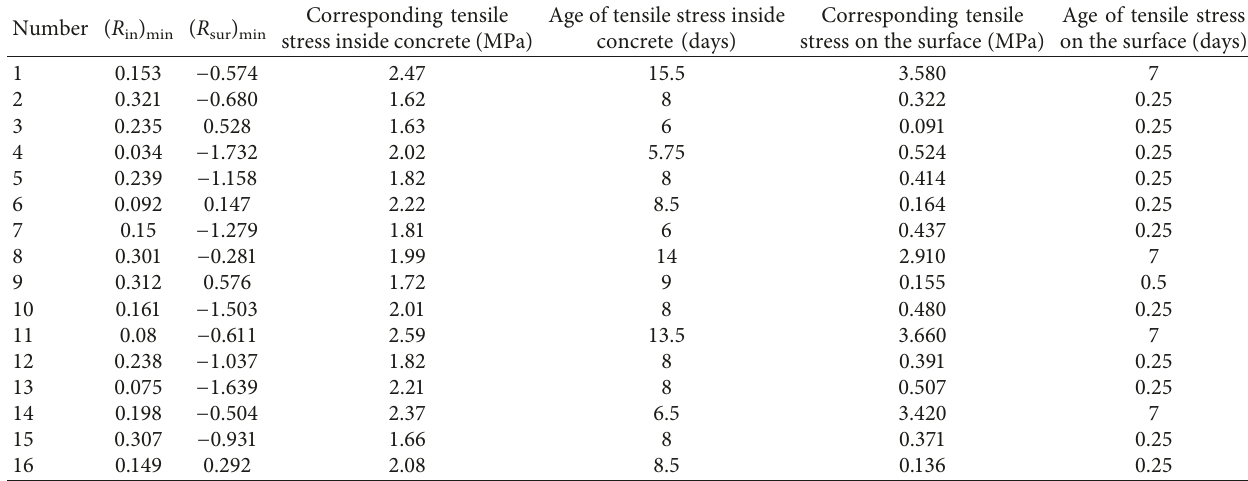
Number ( R in ) min ( R sur ) min